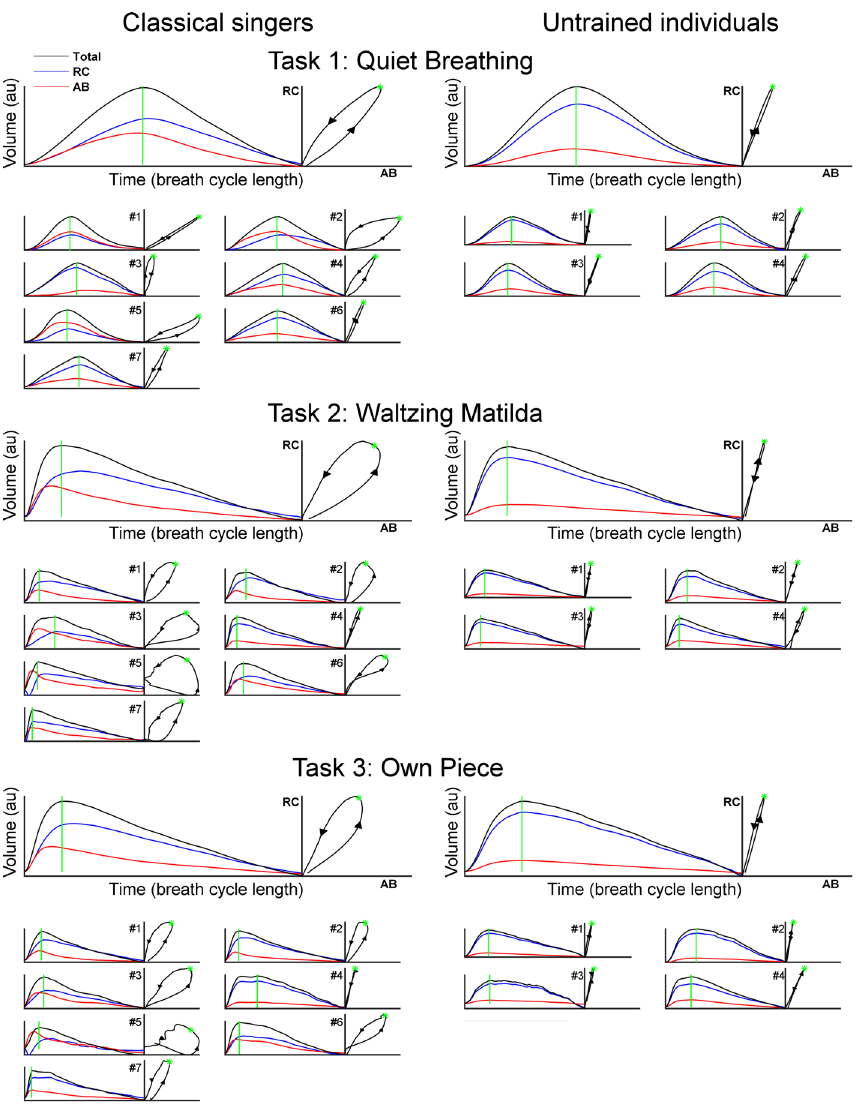
Fig 7. Typical breathing patterns of classical singers and untrained individuals extracted using principal component analysis. The group ’ s typical patterns are represented in the large axes, whereas patterns of individual participants are represented in small axes. Volume waveforms are shown with the corresponding Konno-Mead plots of RC and AB movements. The arrowheads in the Konno-Mead plots illustrate the time course, i.e. ascending and descending arrows correspond to inspiratory and expiratory phases, respectively. The start of expiration phase is marked in green both in the time plots and Konno-Mead plots. Note: The raw data shown in Fig 3 were recorded from classical singer #1 and untrained individual